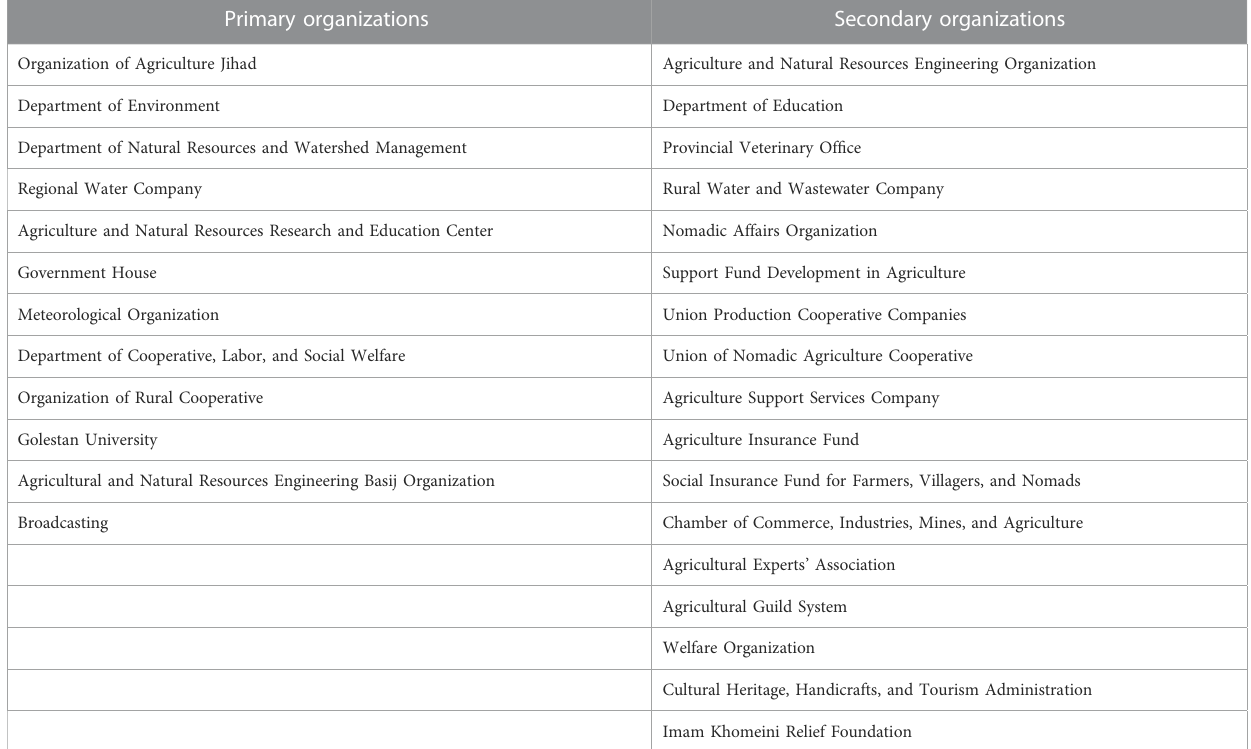
TABLE 5 Primary and secondary organizations in terms of information exchange of watershed